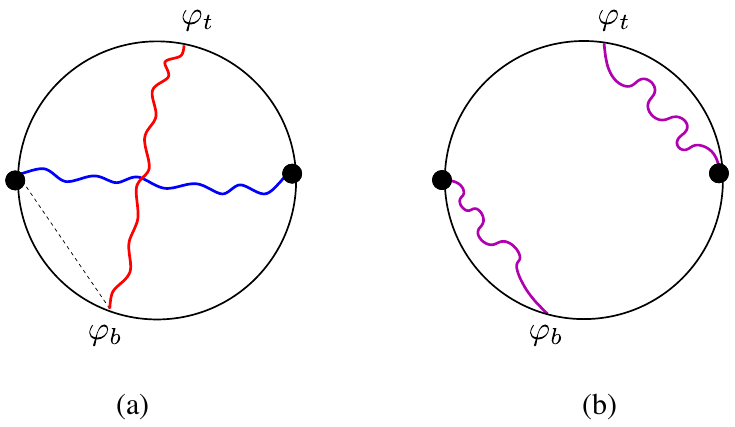
Figure 5 . (a) We consider the action of the charges. We have matter (cid:12)elds propagating from the bottom to the top indicated in red. These cause some backreaction on the boundary